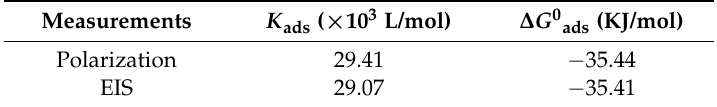
Table 4. The relevant thermodynamic parameters for copper from Langmuir adsorption isotherm.